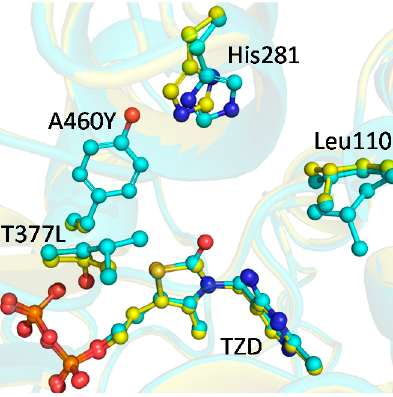
Figure 3. Superposition of the active sites of wt BFDC (yellow) and the BFDC T377L/A460Y variant (cyan) reveals a shift in the position of His281 accompanied by multiple conformations of Leu110. In addition, ThDP was oxidized to thiamin thiazolone diphosphate (TZD). Figure prepared using PyMOL (Schrödinger, Inc., Portland, OR USA) using data from PDB ID 1BFD ( wt BFDC) and 4MZX (BFDC T377L/A460Y).